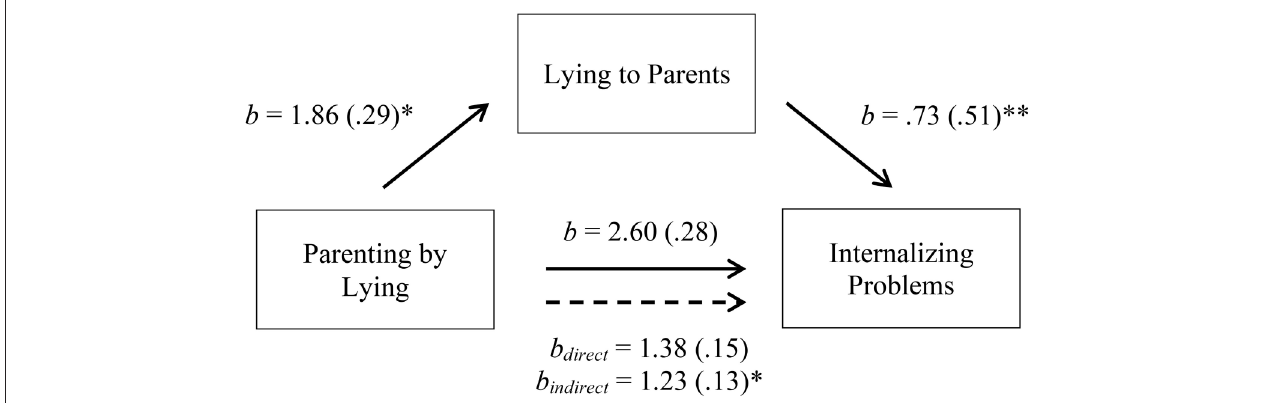
FIGURE 2 | Indirect-only mediation model between parenting by lying and internalizing problems. The solid lines represent the simple linear regressions (paths a, b, and c); the dotted line represents the bootstrapped direct and indirect effects of X on Y after controlling for M. Bracketed values indicate the standardized Beta coefficient. * p < 0.05, ** p < 0.001.